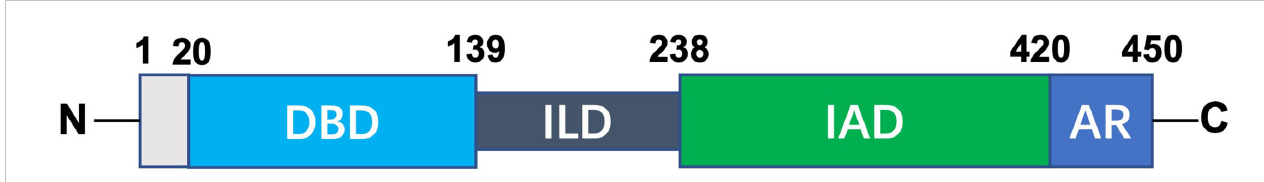
FIGURE 2 Schematic diagram of IRF4 structure. IRF4 consists of three structural domains: a highly conserved N-terminal DNA-binding domain (DBD), a variable C- terminal IRF association domain (IAD) and an intermediate linker domain (ILD). The DBD is characterized by fi ve conserved tryptophans enabling it to form a helix – loop – helix motif that facilitates DNA binding. IAD is a protein – protein interaction domain that mediates the interaction of IRF4 with itself or multiple distinct transcription factors. IAD also contains a C-terminal auto-inhibitory region (AR) which physically interacts with DBD and results in low DNA binding af fi